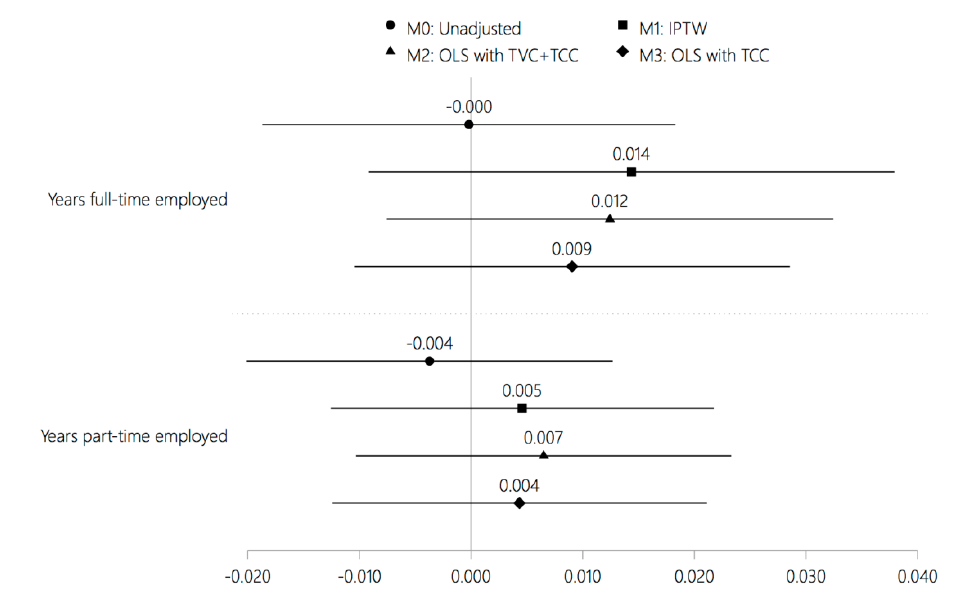
Figure 5 : Estimated average marginal effect of years in full-time and part-time employment on risk of child overweight around age